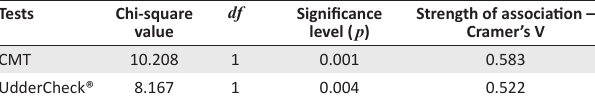
TABLE 5: Association between Draminski® and other tests used to screen quarter milk samples for subclinical mastitis.